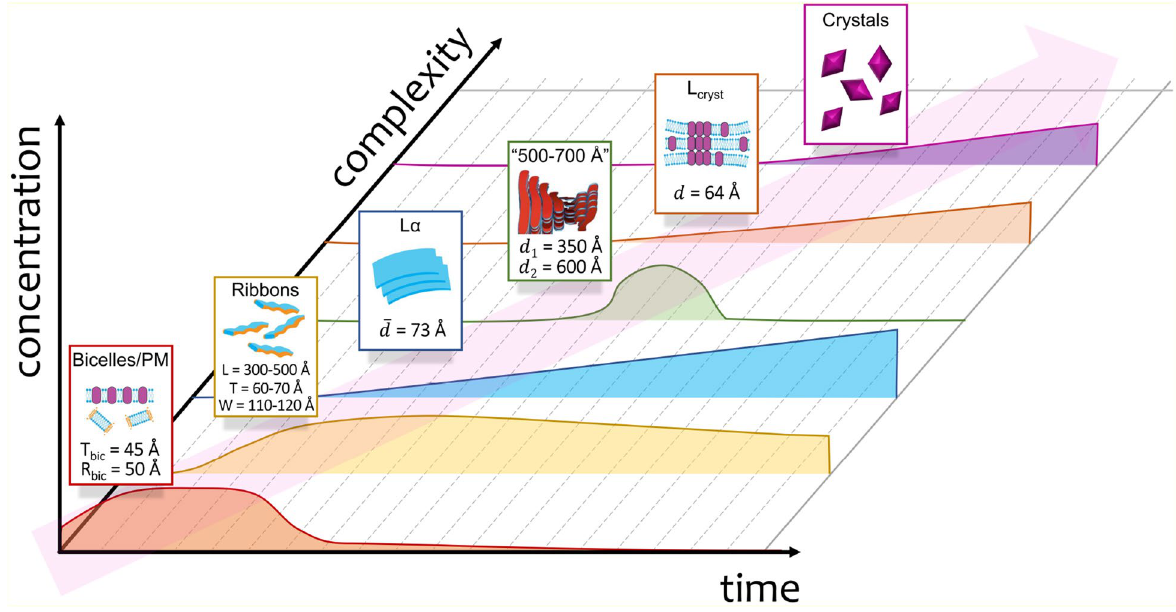
Figure 7. The scheme demonstrating the evolution of the crystallization matrix and sequential appearance/ disappearance of various structural elements: a mixture of bicelles and PMs, ribbons, the lamellar phase Lα, the “phase 500–700 Å”, the local lamellar phase L cryst and BR crystals (see more extended description in the main text). Following Katsaras et al. 31 , we present the “phase 500–700 Å” as chiral nematic; however, the true nature of this phase is still unclear. The axis correspond to time, complexity (i.e. number/quantity of the new appeared structural element), and concentration, respectively. Concentration is given in arbitrary units (structural elements have different concentration ranges; here the concentration is presented on the same scale for clarity; dependencies of concentrations vs. time are shown